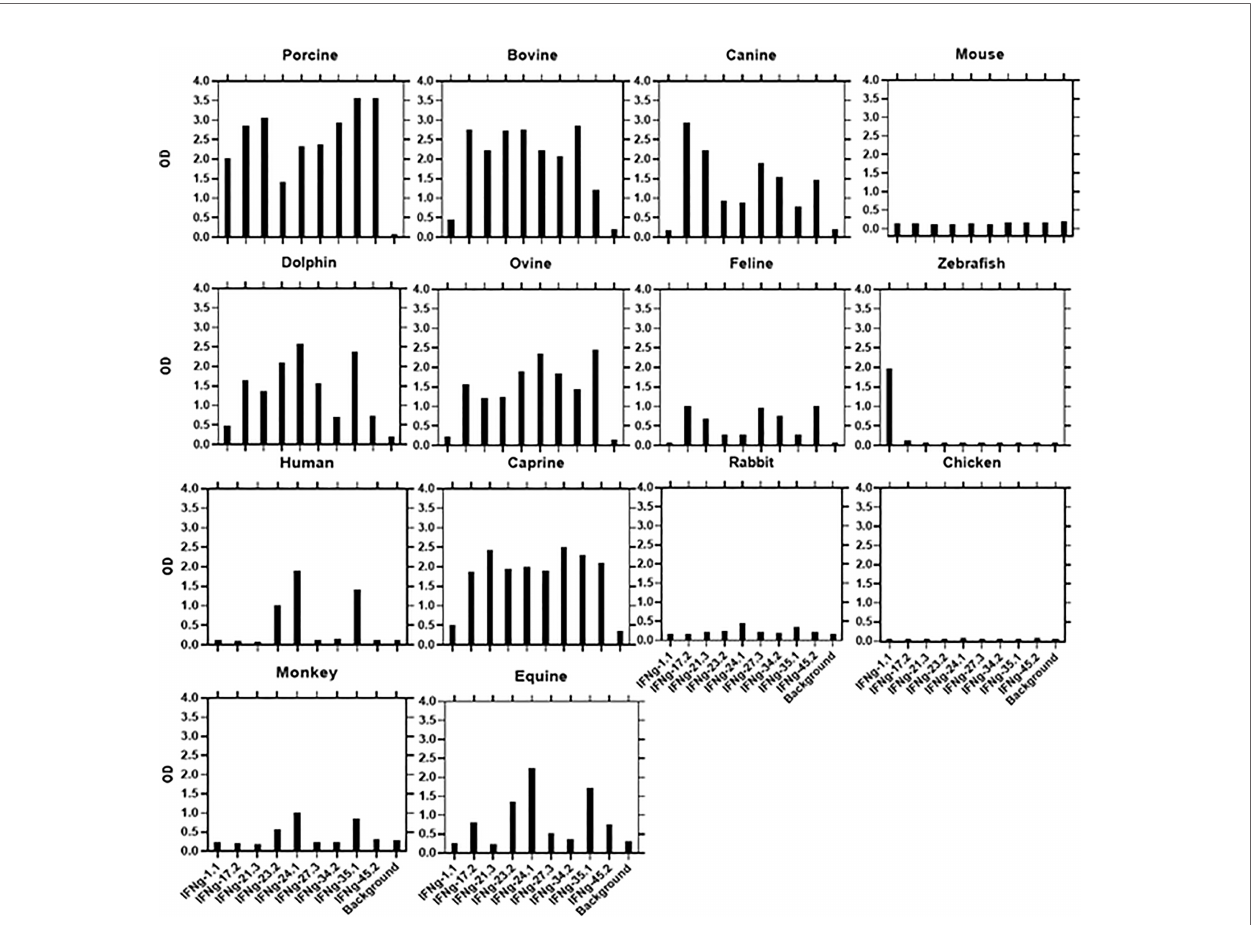
FIGURE 2 | Cross-species binding of a PoIFN g mAbs. A panel of biotin-labeled a PoIFN g mAbs were tested for their ability to bind puri fi ed orthologous rIFN g proteins from several species as described in M&M. Shown are mean ODs of duplicates for the binding of 1 m g/ml for each